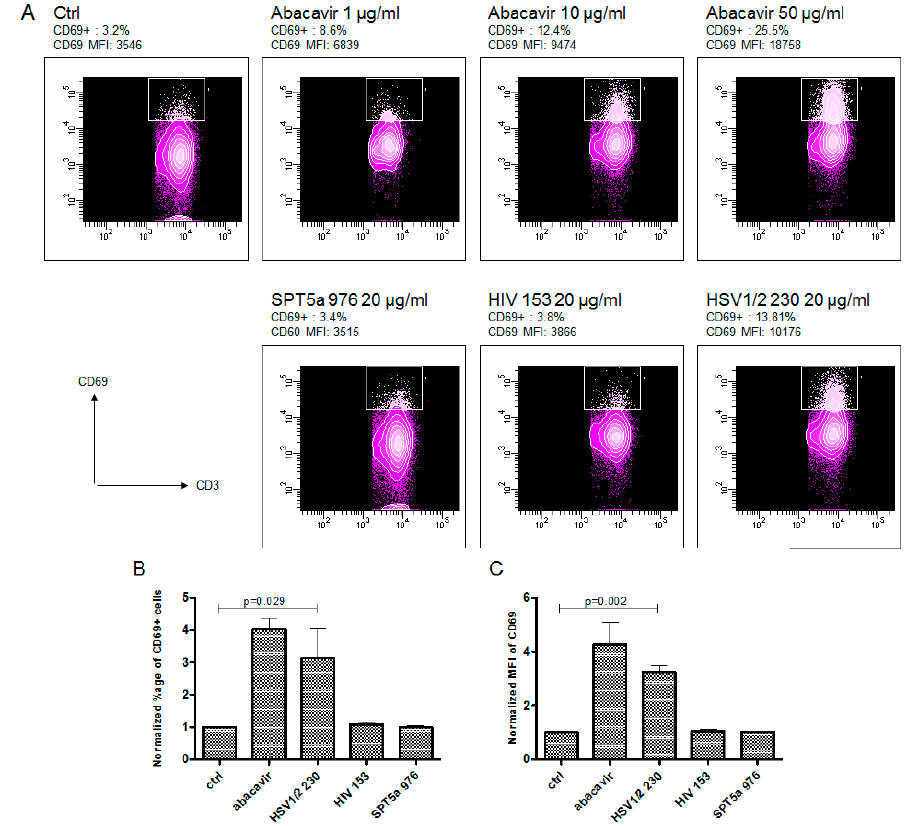
Figure 2. An abacavir-reactive TCR transfectant recognizes a virus peptide. An example of flow cytometric analysis ( A ) shows activation of JRT3-CD8 cells expressing a TCR derived from an abacavir-reactive T cell clone (BeS-B7) following stimulation with antigen presenting cells (721.221) expressing HLA-B*57:01 with increasing concentrations of abacavir (upper row) or with the different tested peptides (lower row). TCR transfectants show upregulation of the activation marker CD69 after stimulation with abacavir and VTQQAQVRL (HSV 230). The experiment was repeated 3 times; upregulation of CD69 + cells and mean fluorescence intensities of CD69 were normalized to control and are shown in ( B , C ), respectively. Ctrl indicates vehicle control (no peptide, no abacavir). Indicated p -values were calculated using the Student’s t -test.